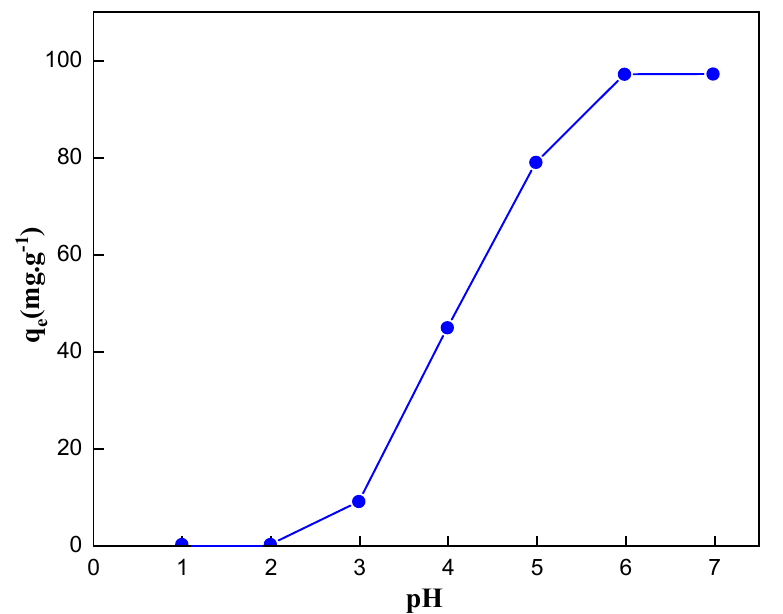
Figure 5. The effect of pH on the adsorption capacity of SiN-imd-py towards Cu(II). Adsorption condition: V = 10 mL, m = 10 mg of adsorbent and optimum concentration = 150 mg L − 1 for Cu(II) and t = 25 min at 25 °C.